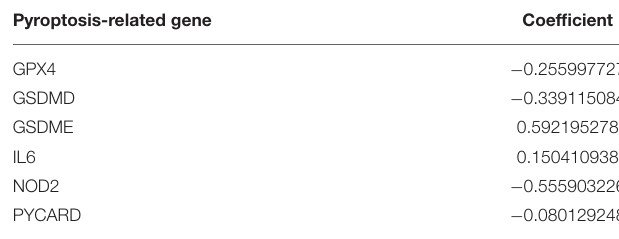
TABLE 1 | Six pyroptosis-associated genes and their coefficient